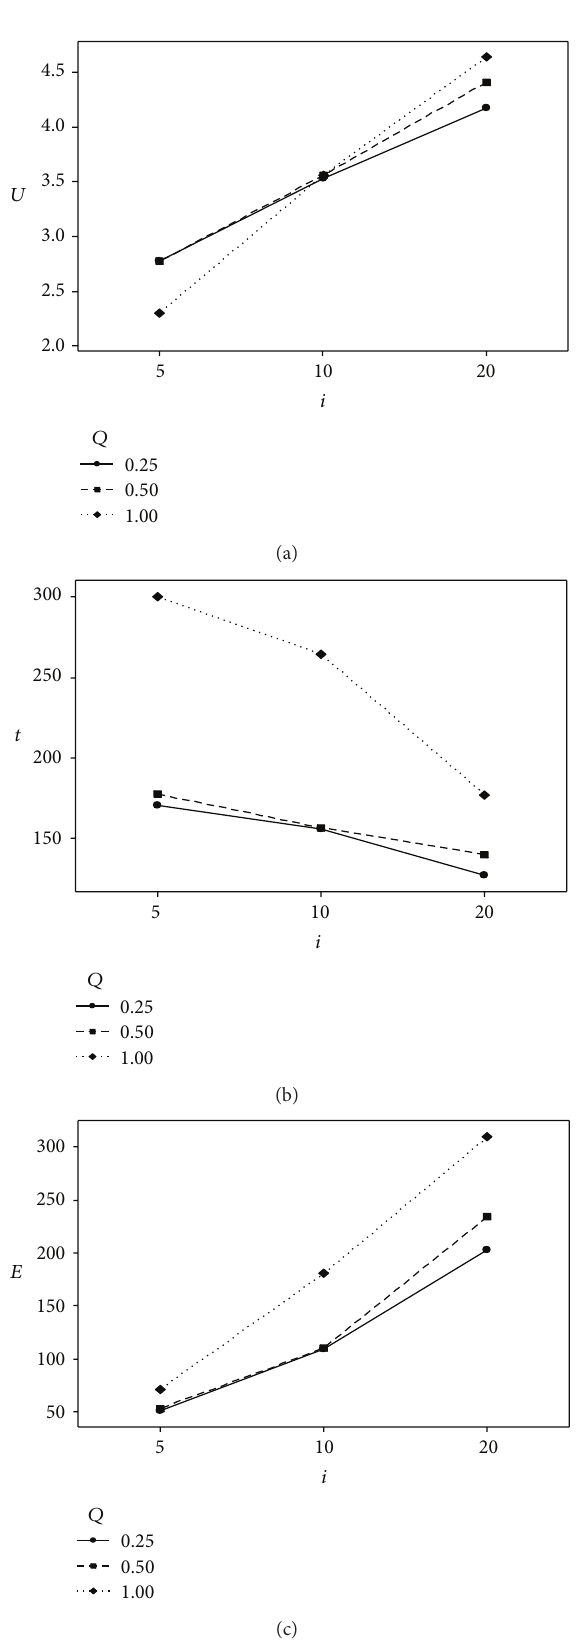
Figure 8: Cross-effects diagrams of 𝑄 and 𝑖 for (a) 𝑈 , (b) 𝑡 , and (c) 𝐸 . Experiments performed in the EC reactor applying current densities 𝑖 of 5, 10, and 20Am −2 and flow rates 𝑄 of 0.25, 0.50, and 1.00Lmin −1